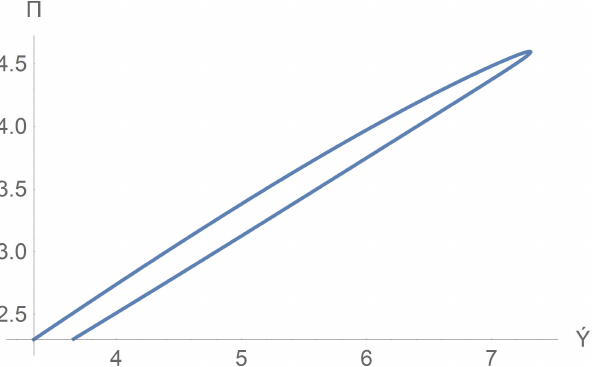
Figure 8. Hysteresis of the rheological stress–strain curve Π = Π ( ˙ γ ) .